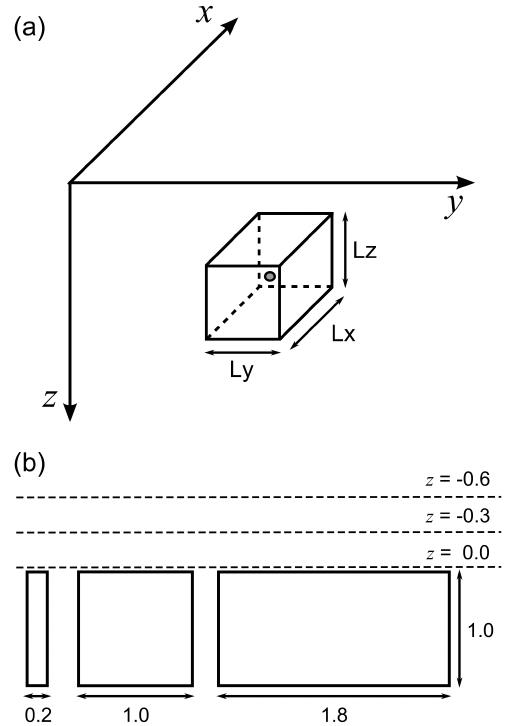
Figure 4. Robustness against non-spherical sources. (a) Rectangu- lar prism with dimensions Lx , Ly and Lz and centre at the grey dot. (b) Projection of three prisms on the plane yz . All prisms have top at z = 10m and side lengths Lx = Lz = 1000m. The horizon- tal dimension Ly of each prism is equal to 200, 1000 and 1800m. The dashed lines represent the vertical coordinate z of three differ- ent horizontal planes above the prisms. For convenience, all coor- dinates and lengths are normalized by the numerical value of Lz (1000m) to obtain dimensionless quantities.